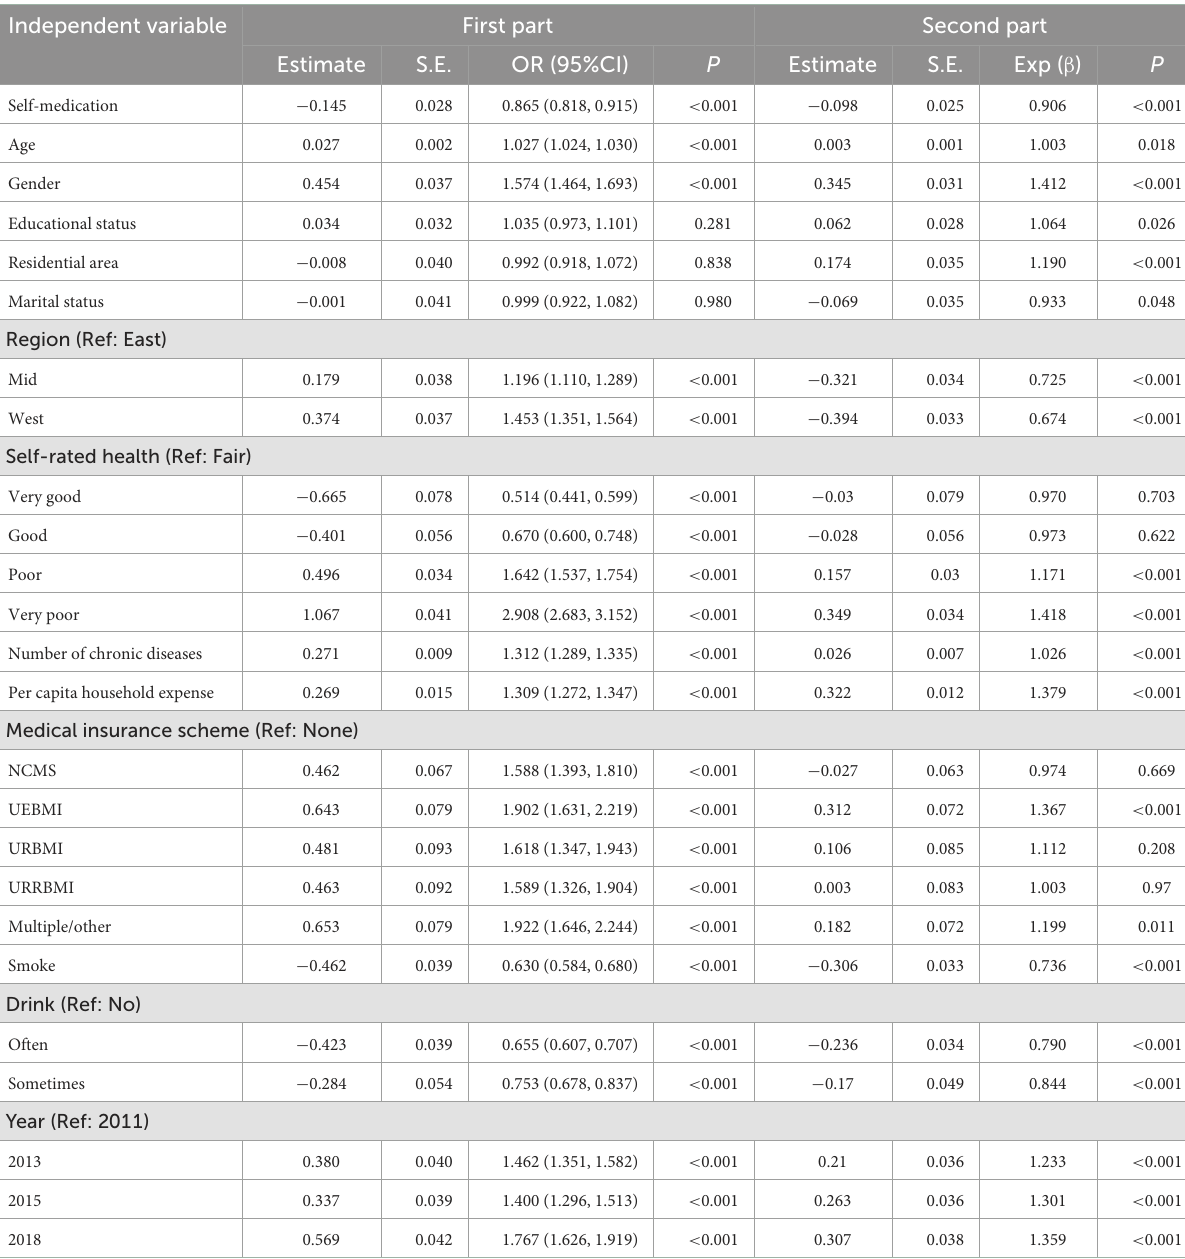
TABLE 4 Parameter estimates from two-part mixed-effects model on inpatient expenditures. Independent